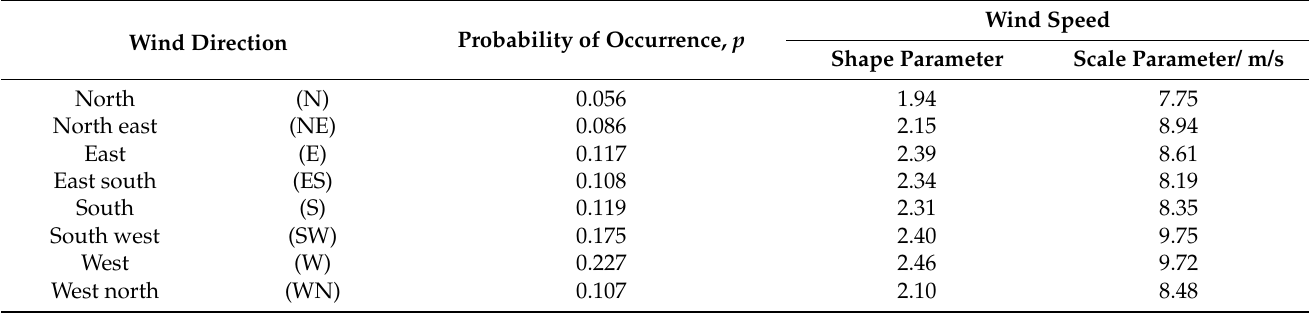
Table 1. Parameter of the wind speed depending on the wind